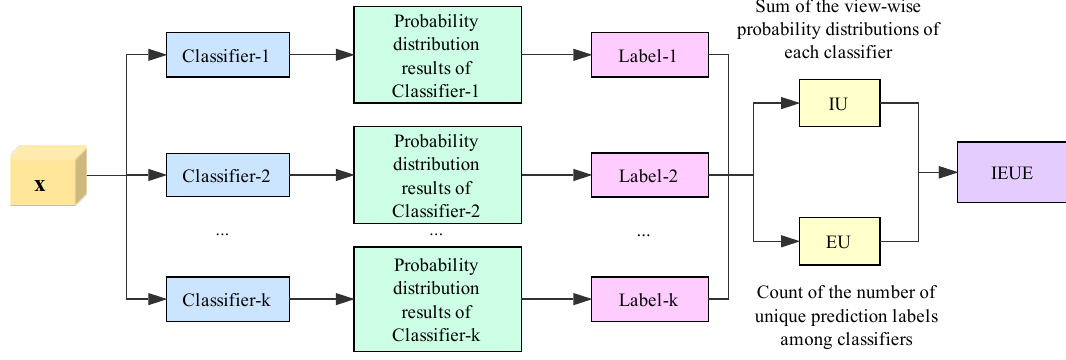
Figure 3. Schematic illustration of how to calculate the IEUE